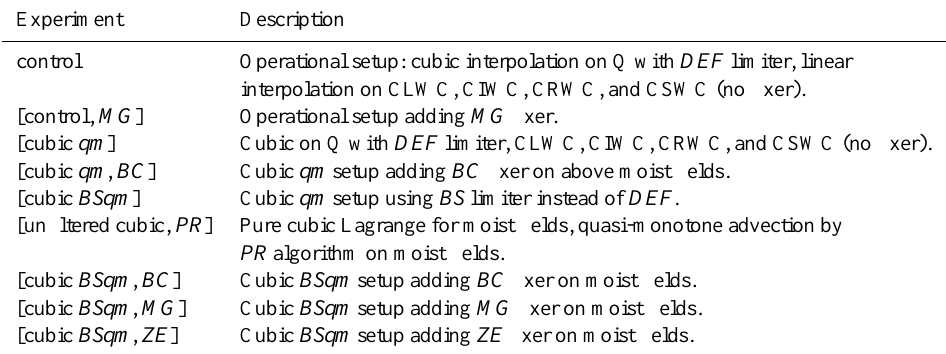
Table 1. List of 12-month forecast experiments. Experiment Description control Operational setup: cubic interpolation on Q with DEF limiter,